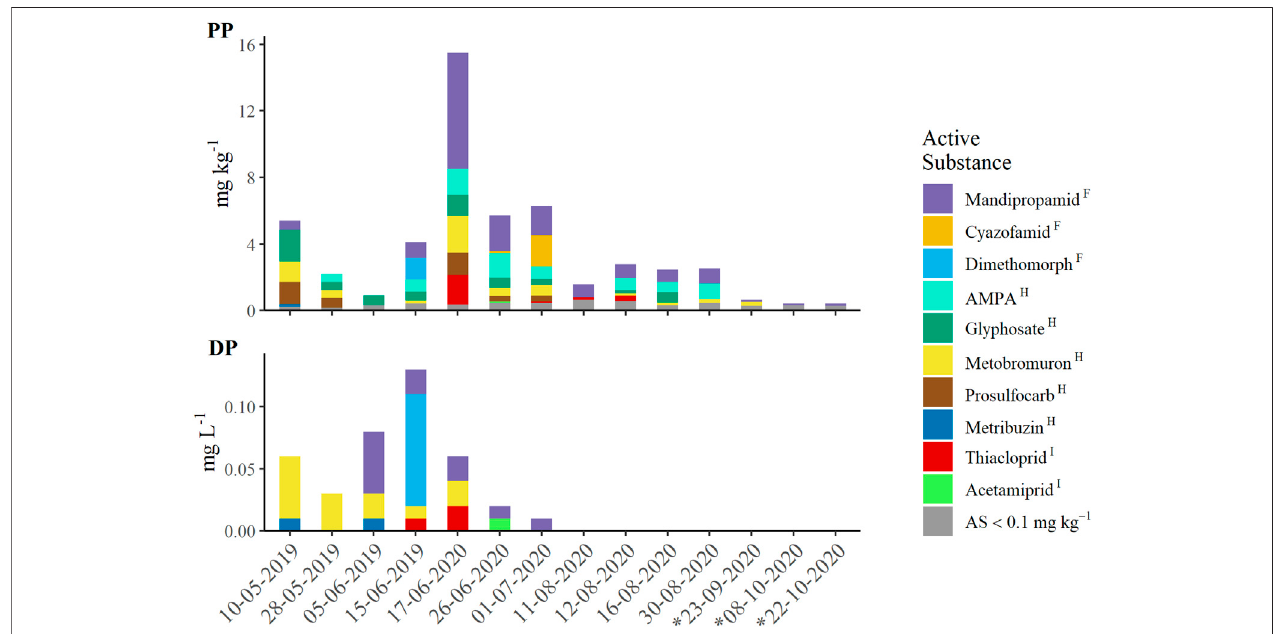
FIGURE 3 | Concentrations of active substances (AS) detected in runoff during each event in the particulate (PP) and dissolved (DP) phase. Superscript in legend denotes: F Fungicides, H Herbicides,and I Insecticides.AllASinaspeci fi ceventwithacontentinthePPbelow0.1 mg kg − 1 aregroupedforvisualization.*Fortheevents after 23-09-2020, Glyphosate and AMPA are excluded due to point source